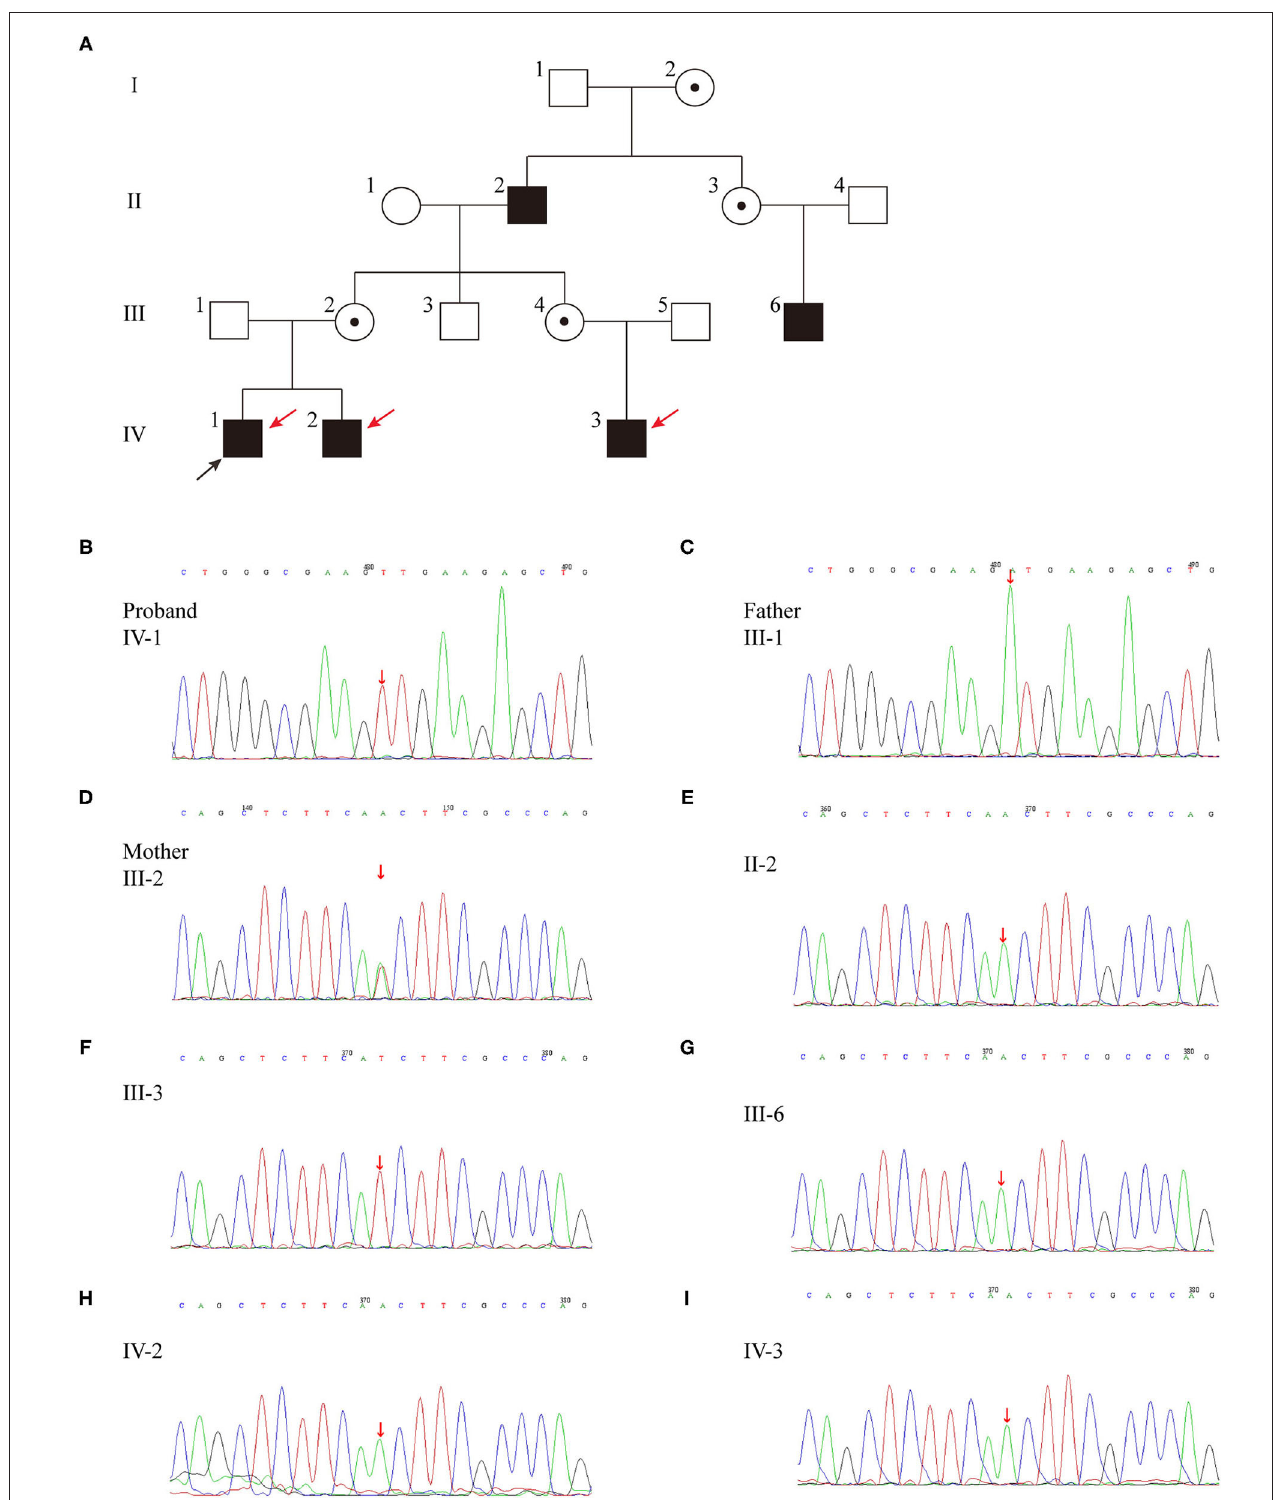
FIGURE 1 | (A) Pedigree of the family affected with X-linked recessive inherited NDI. Family members are identified by generations and numbers. Squares indicate male family members; circles, female members; open symbols, unaffected members; black symbols, the affected with polyuria and polydipsia members; circles with a central dot, obligatory carriers; red arrows, the affected with growth retardation members; black arrow, proband. (B–I) Sequencing results of the AVPR2 mutation. Sequence chromatograms indicate a T to A transition of nucleotide 530.